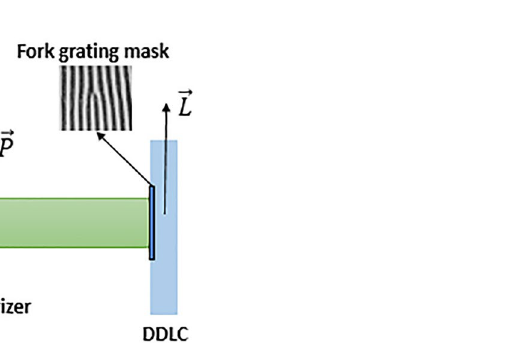
Figure 4. The schematic of the experimental setup to record the fork grating pattern onto cell, −→ L ||−→ P